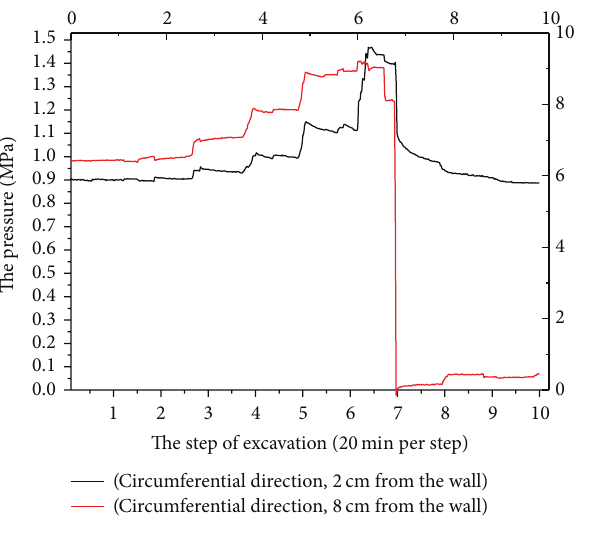
Figure 8: Hoop pressure change curve.